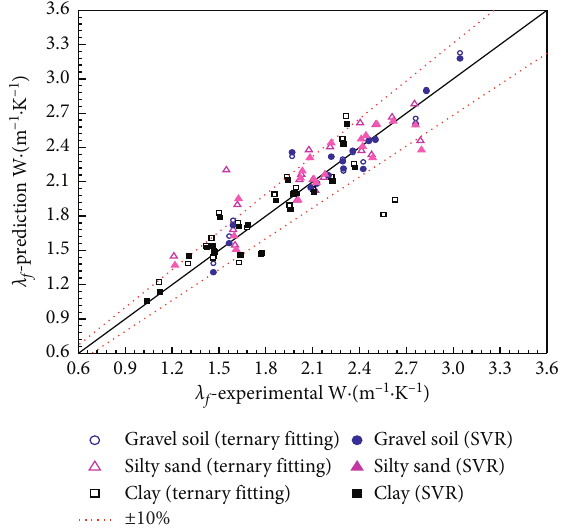
Figure 11: Prediction results of small sample